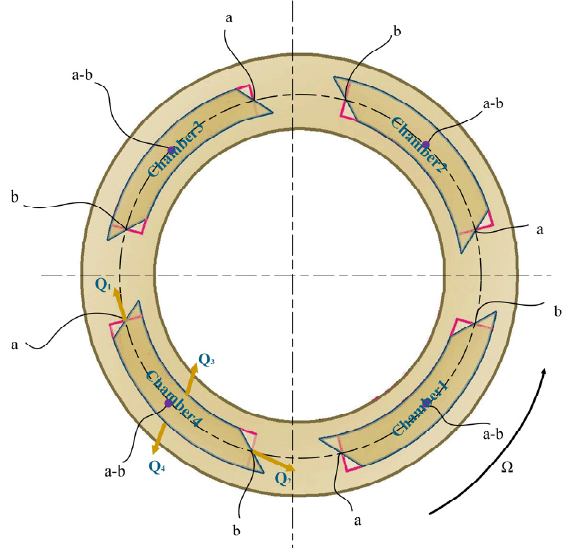
Figure 2. Axial projection of the chamber distributions.